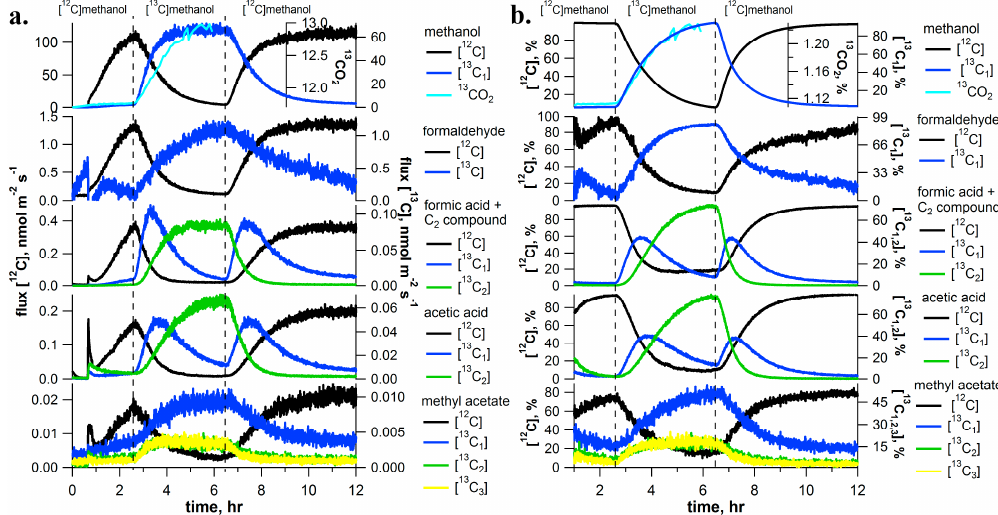
Figure 1. Example [ 13 C]methanol pulse-chase experiment on a detached branch of I. edulis showing real-time [ 13 C]labeling and unlabeling dynamics of C 1 and C 2 volatile metabolites using proton transfer reaction–mass spectrometry (PTR-MS) (absolute emissions in ( a ) and relative emissions in ( b )).